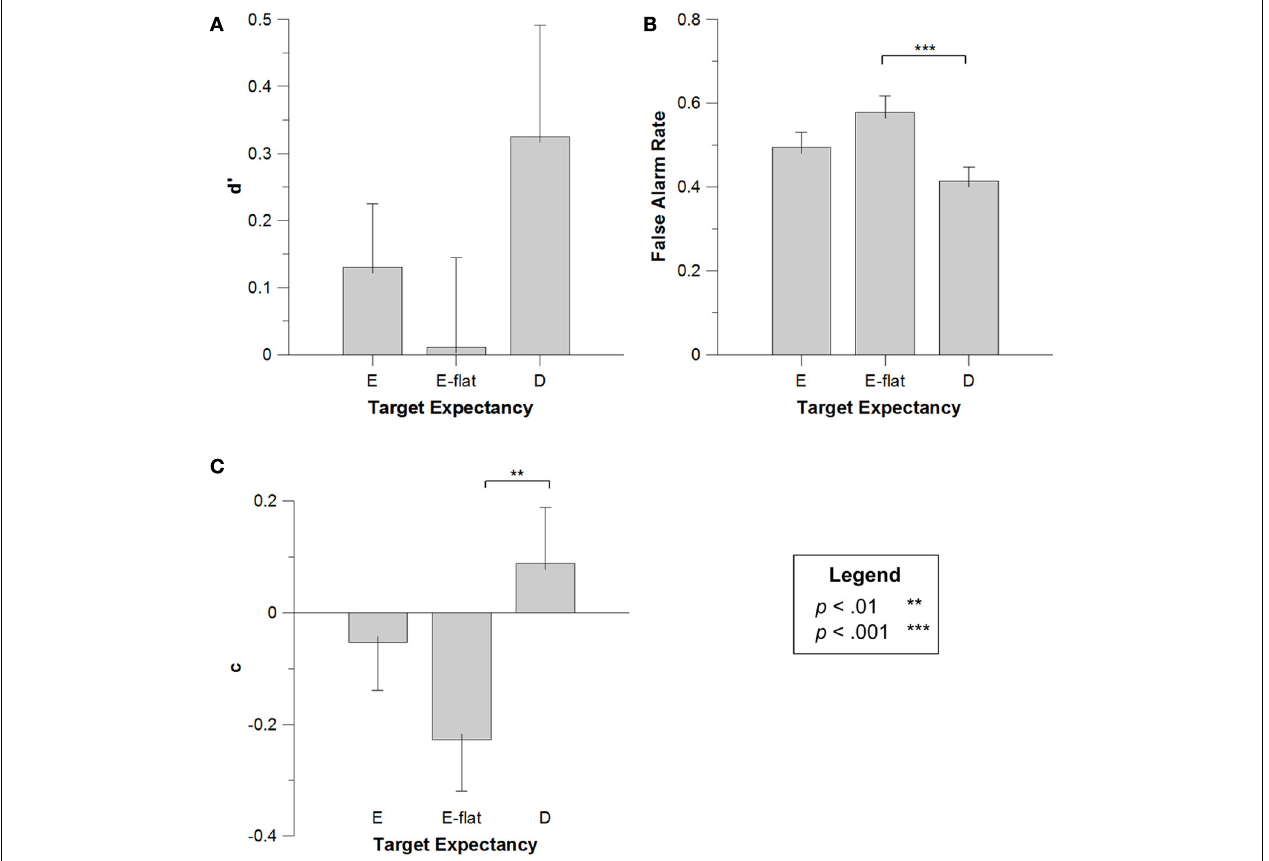
FIGURE 6 | d (cid:2) (A), false alarm rate (B) and c (C) for high, moderate, and low expectancy targets in Experiment 3. Error bars depict the standard error of the mean.